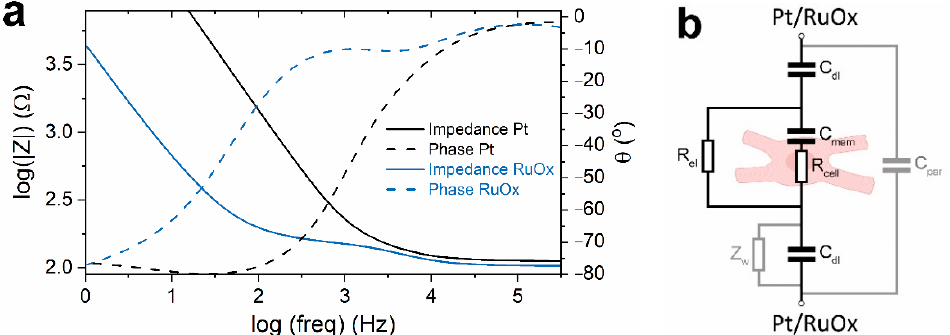
Figure 3. ( a ) Frequency dependence of the system’s impedance in the presence of empty Transwell insert, measured in the hPSC-CMs medium at room temperature. ( b ) Expected equivalent circuit of the system with the hPSC-CMs in place and the (open) Warburg element as surface porosity model in the case of the RuOx nanorods. Abbreviations: C dl , double layer capacitance; R el , electrolyte resistance; C mem , cell membrane capacitance; R cell , cytoplasm resistance; C par , parasitic capacitance; Z w , Warburg element.